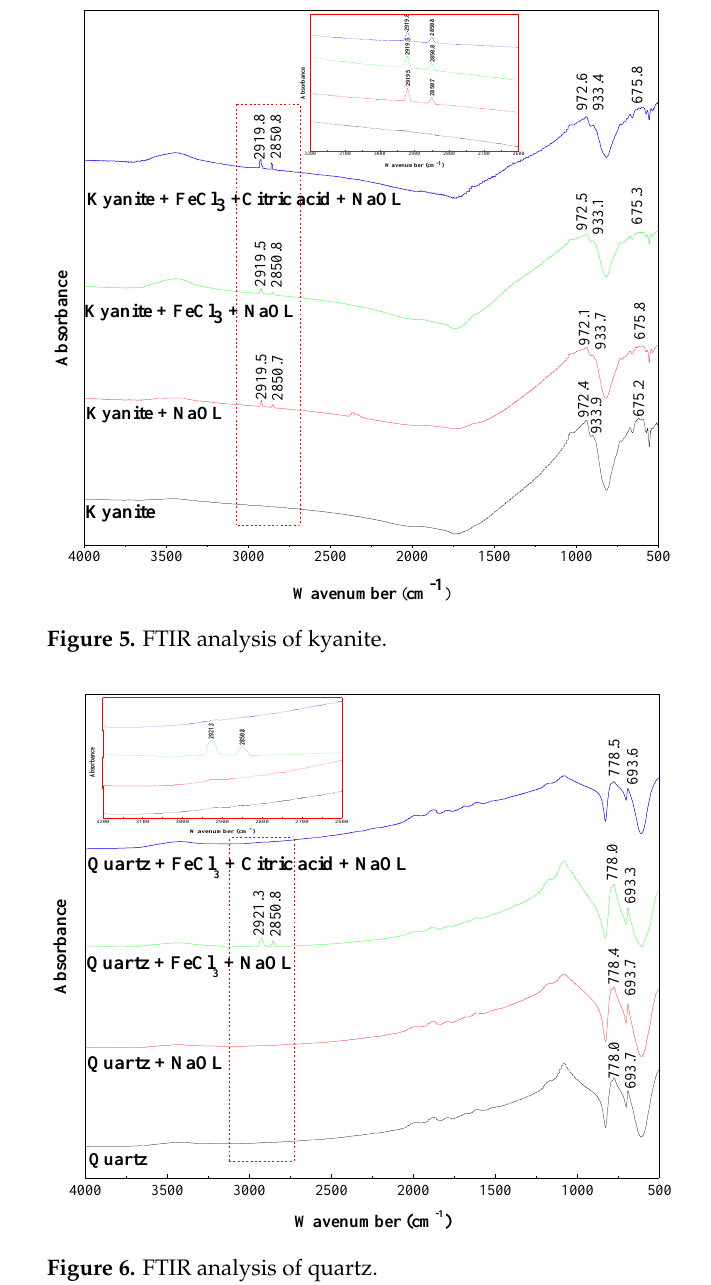
Figure 6. FTIR analysis of quartz. The kyanite peak at approximately 675 cm − 1 corresponded to the Si–O tetrahedron symmetrical bending vibration peak; however, the kyanite peaks at approximately 972 and 933 cm − 1 were attributed to the Si–O asymmetric stretching vibration of the